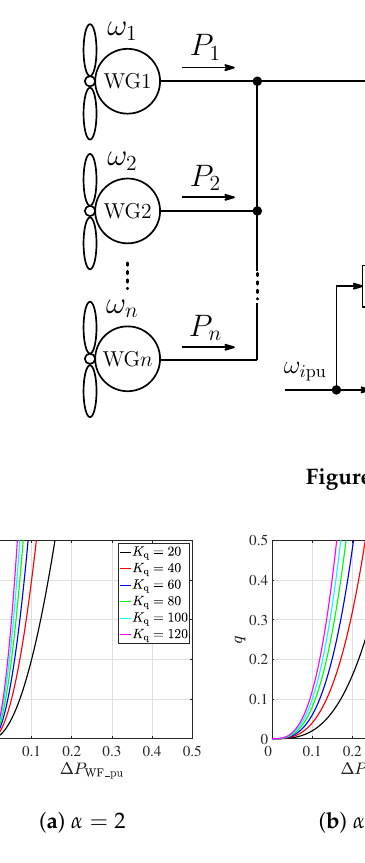
Figure 6. q vs. ∆ P WFpu